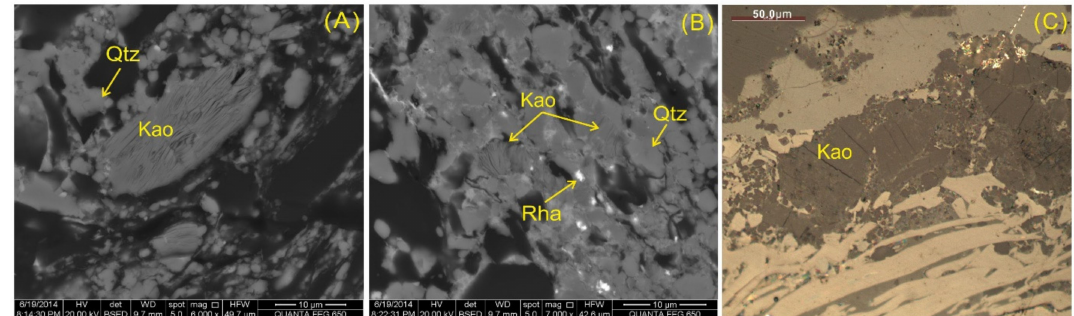
Figure 7. Kaolinite in sample B2-2. ( A ) Lump kaolinite and authigenic quartz. ( B ) Book-like kaolinite, quartz, and rhabdophane. ( C ) Kaolinite likely formed from in situ alteration of feldspar. ( A , B ) Back-scattered electron images. ( C ) Optical microscope, reflected light. Kao, kaolinite. Qtz: quartz. Rha: